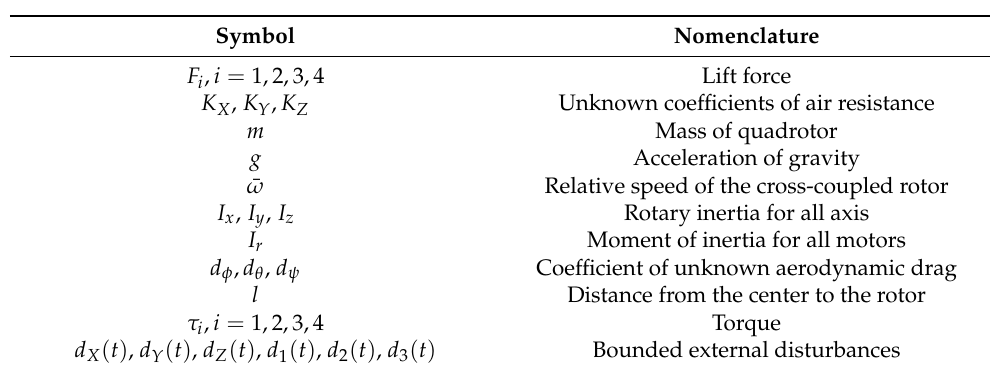
Table 1. The notation for the